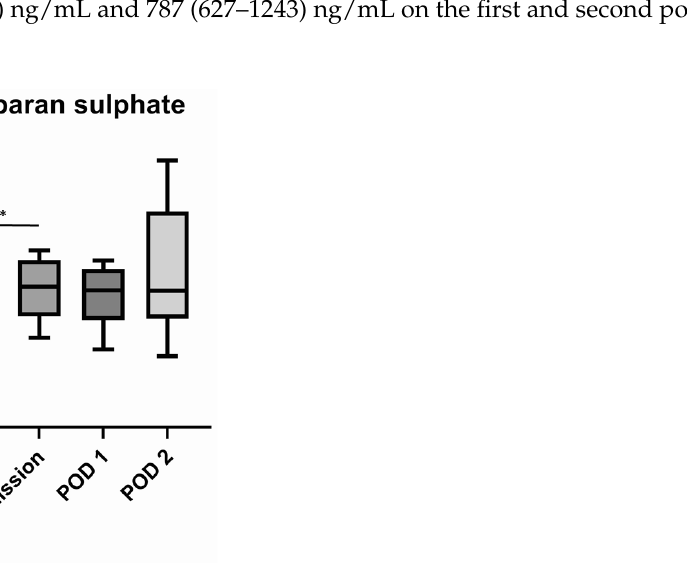
Figure 1. Concentration of heparan sulphate before and after surgery and on postoperative days (POD) 1 and 2. Box – Whisker Plot (Tukey method). * = p ≤ 0.05.